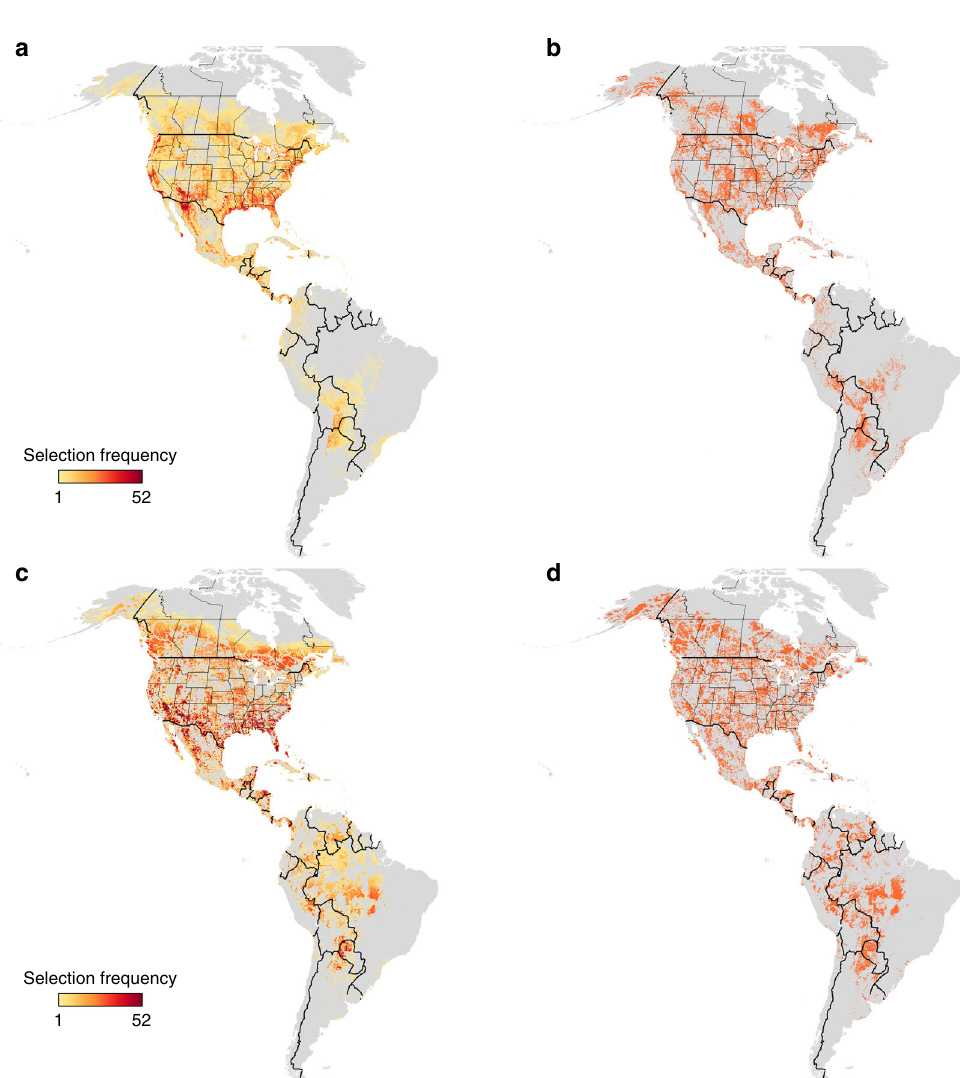
Fig. 1 Single population comparison results. Areas prioritized for weekly and yearly planning under a shared-use approach allowing for the inclusion of human dominated landscapes vs. an intact habitat approach that excludes areas of high human footprint are shown. The prioritization is based on a target of 30% of global populations of 117 species of Neotropical migratory birds when each species range is considered as a single population. a = shared-use, weekly, b = shared-use, yearly, c = intact habitat, weekly, d = intact habitat, yearly. Panels a and c show how often (1, light yellow to 52, dark red) areas were selected across the weekly solutions. Panels b and d show whether an area was selected in a solution ( = red). Supplementary Fig. 2 presents a more